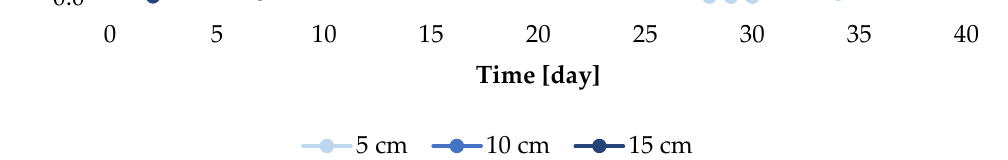
Figure 6. Evaporation intensity, E n , after the injection dose of 450 cm 3 at depths of 5, 10 and 15 cm.